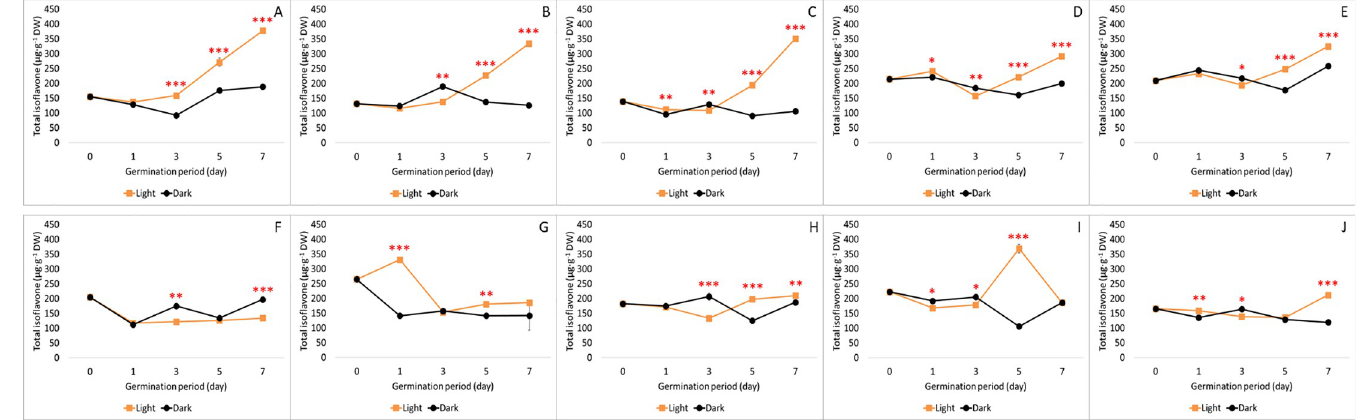
Fig 2. Changes in total isoflavones of small-seeded (A–E) and large-seeded (F–J) soybeans during germination under light and dark conditions. Values are the mean of three replicate determinations (n = 3) ± standard deviation. Statistical significance was shown by a t-test between the germination under light and dark conditions at the each time point ( ��� p < 0.001, �� p < 0.01, � p < 0.05). A, Socheongja; B, Youngwoljwinuni B/G; C, Dawonkong; D, Yaksunkong; E, Youngwoljwinuni B/Y; F, cheongja3; G, GWS 148; H, Daewonkong; I, GWS 140; J, Taekwangkong.